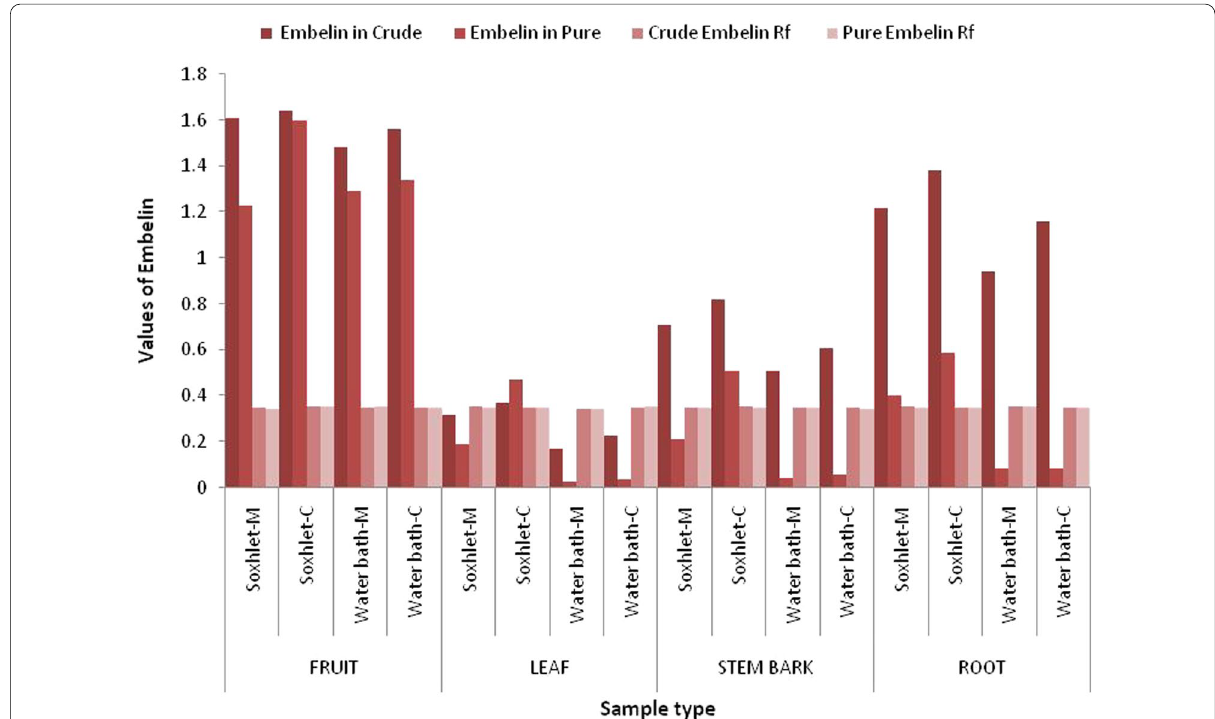
Fig. 3 Comparative graph between embelin content and its Rf